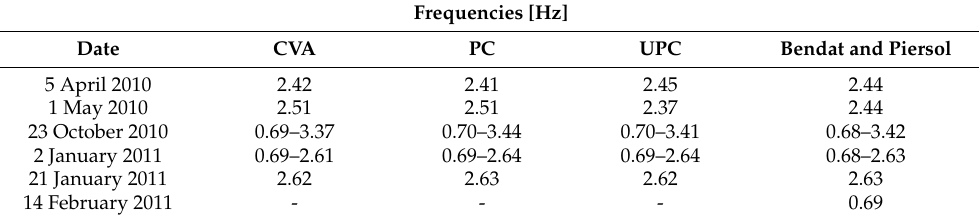
Table 6. Identified frequencies in the north-south direction for the parametric and nonparametric